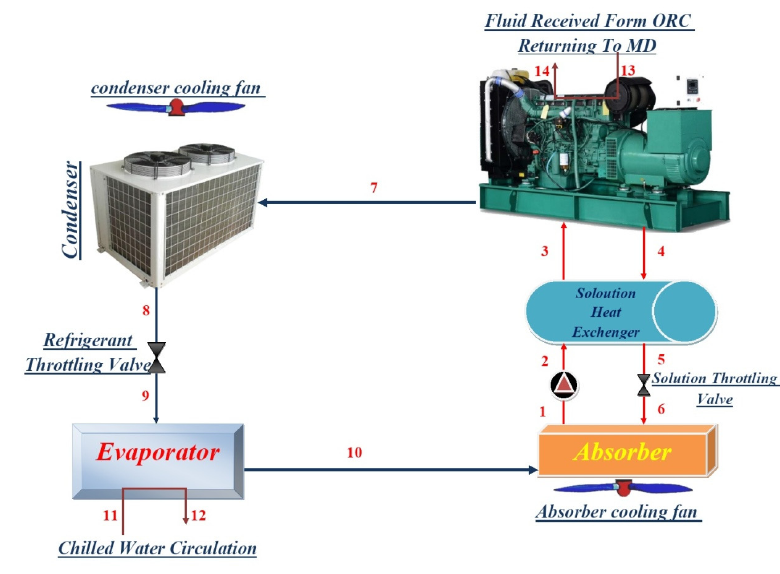
Figure 4. Schematic of a single effect absorption cooling cycle .